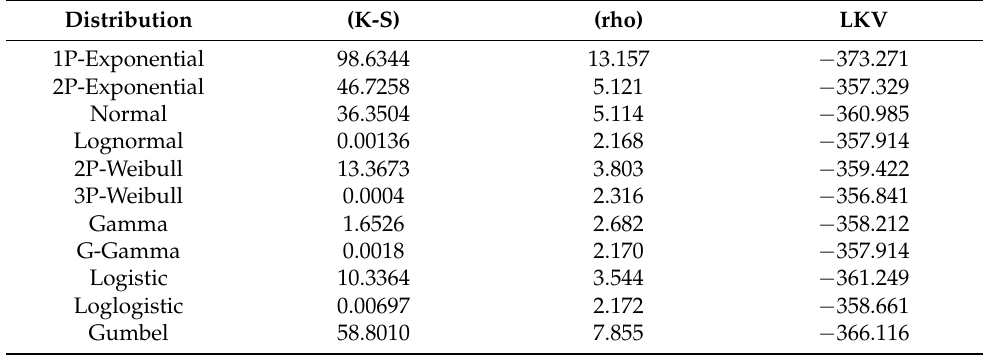
Table 2. Values of factors for hatchback body